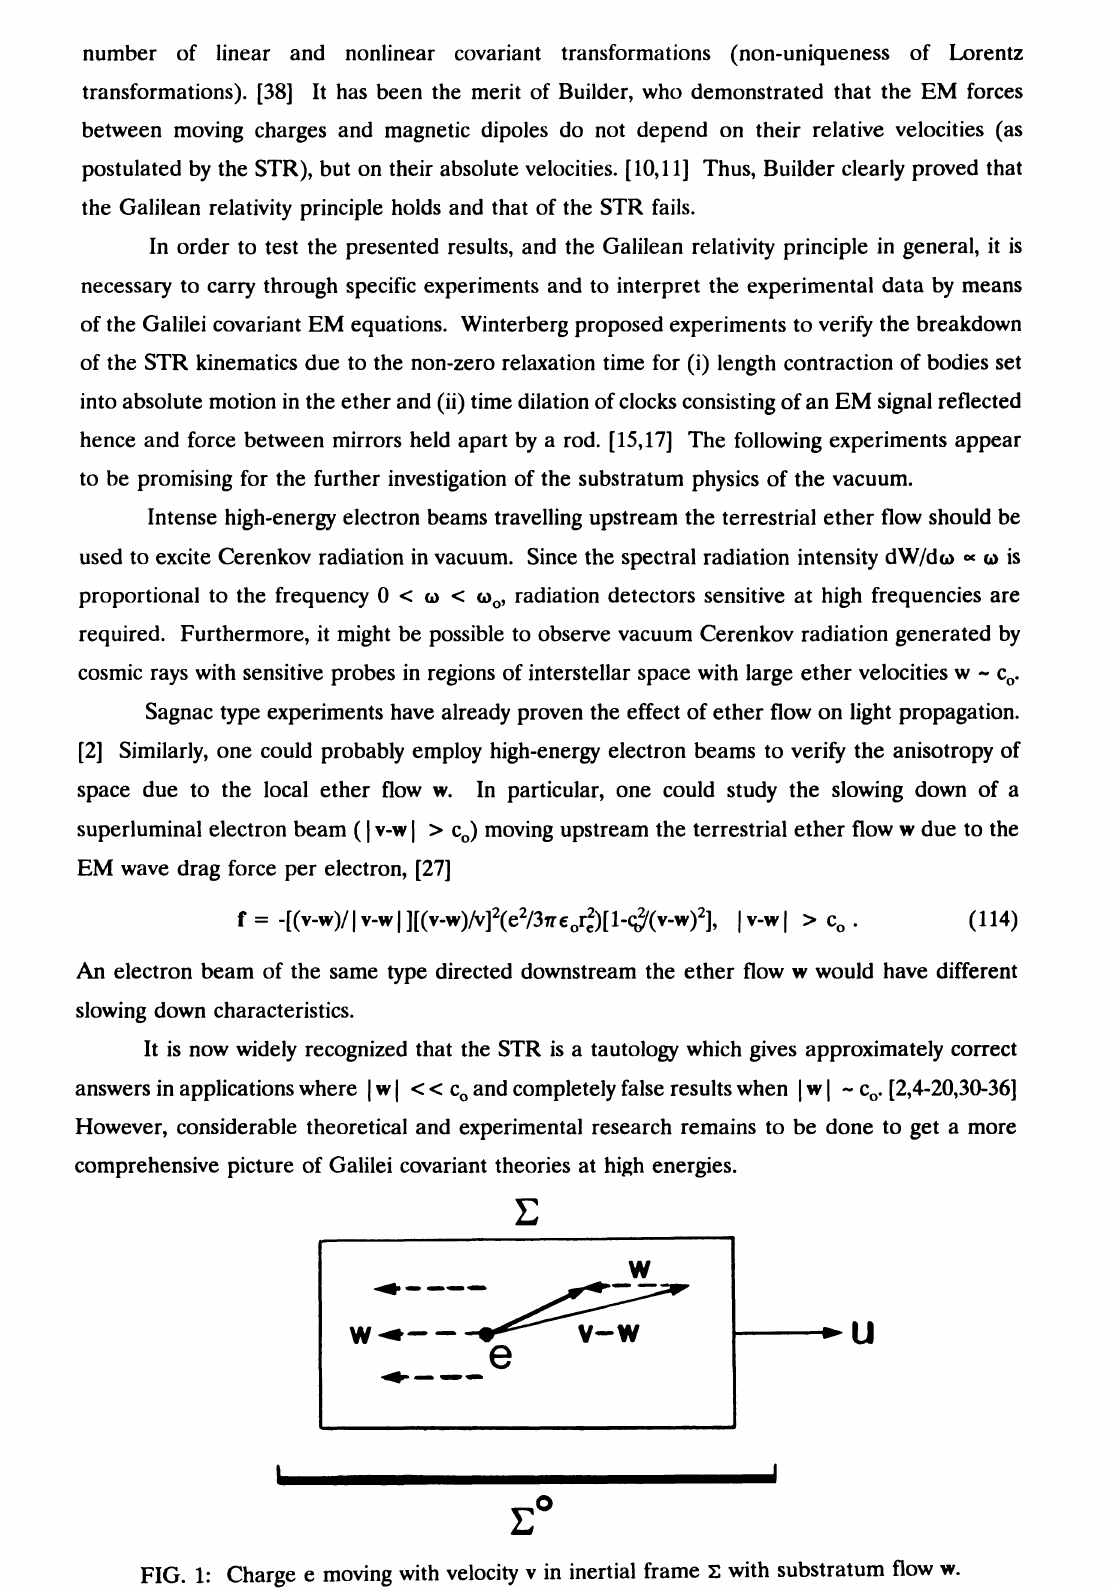
FIG. 1: Charge e moving with velocity v in inertial frame x with substratum flow